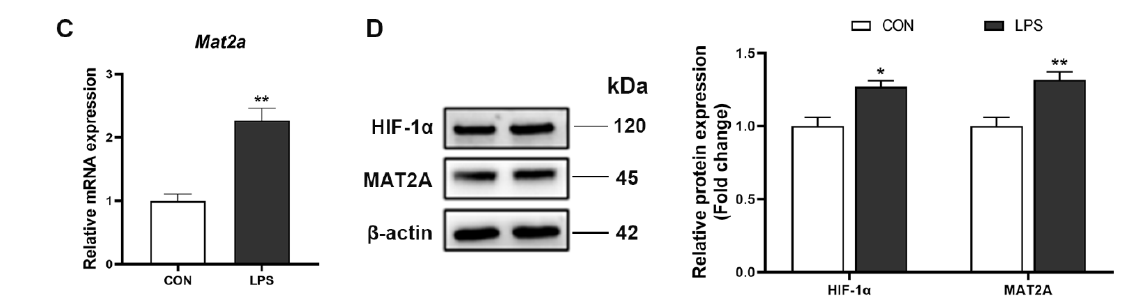
Figure 6. The content of ROS, HIF-1 α , and MAT2A in the liver of piglets. ( A ) ROS contents were detected by using dihydroethidium (DHE)-stained liver cryosections in piglets (40 × magnification). Scale bar = 50 µ m. ImageJ analysis was used to quantify the number of ROS-positive cells. ( B , C ) The HIF-1α and MAT2A mRNA levels were examined in the total liver by RT-qPCR. ( D ) HIF-1α and MAT2A protein levels were assessed by western blot, quantified using ImageJ analysis, and normalized to β-actin. n = 4−6 per group. Results are showed as means with SEM represented by a vertical bar. * represents significant differences between the CON group and the LPS group; * p < 0.05, ** p < 0.01, *** p < 0.001.